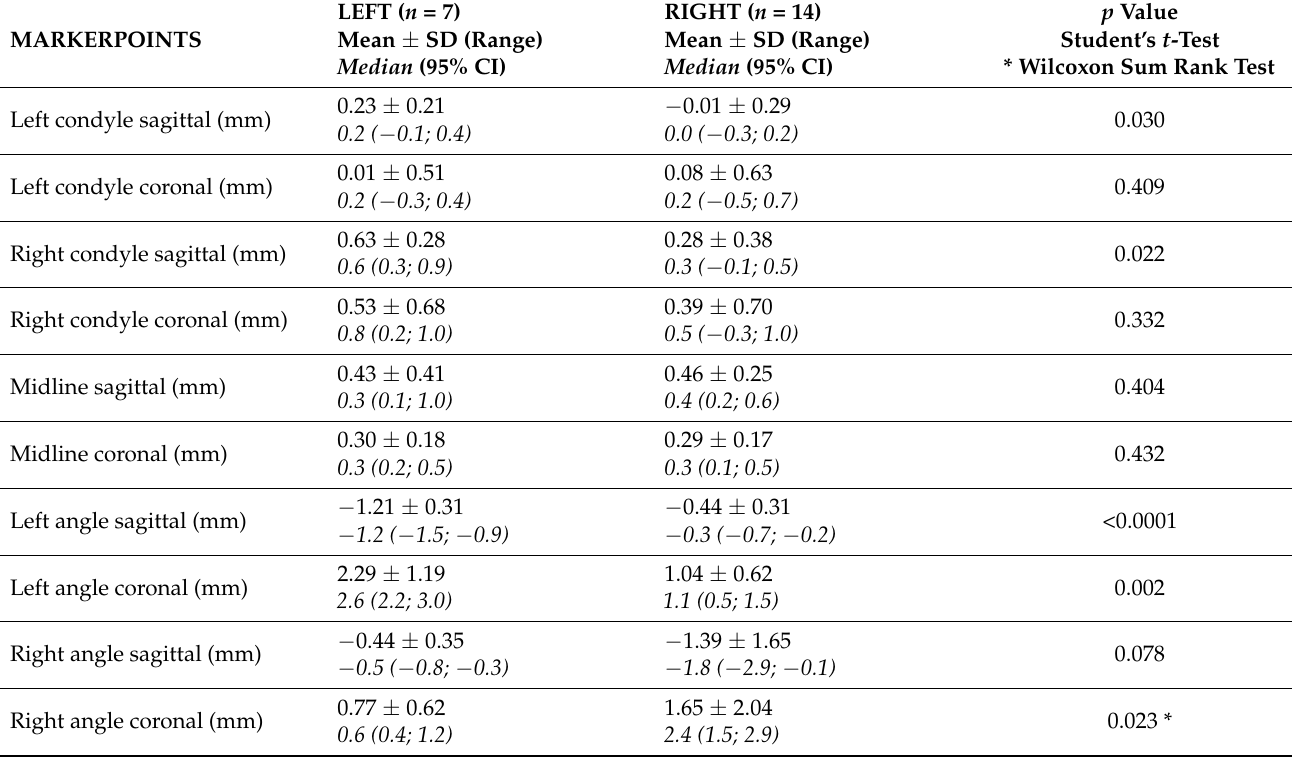
Table 2. Comparison of mandibular marker points through Student’s t -test for patients treated on right-hand and left-hand